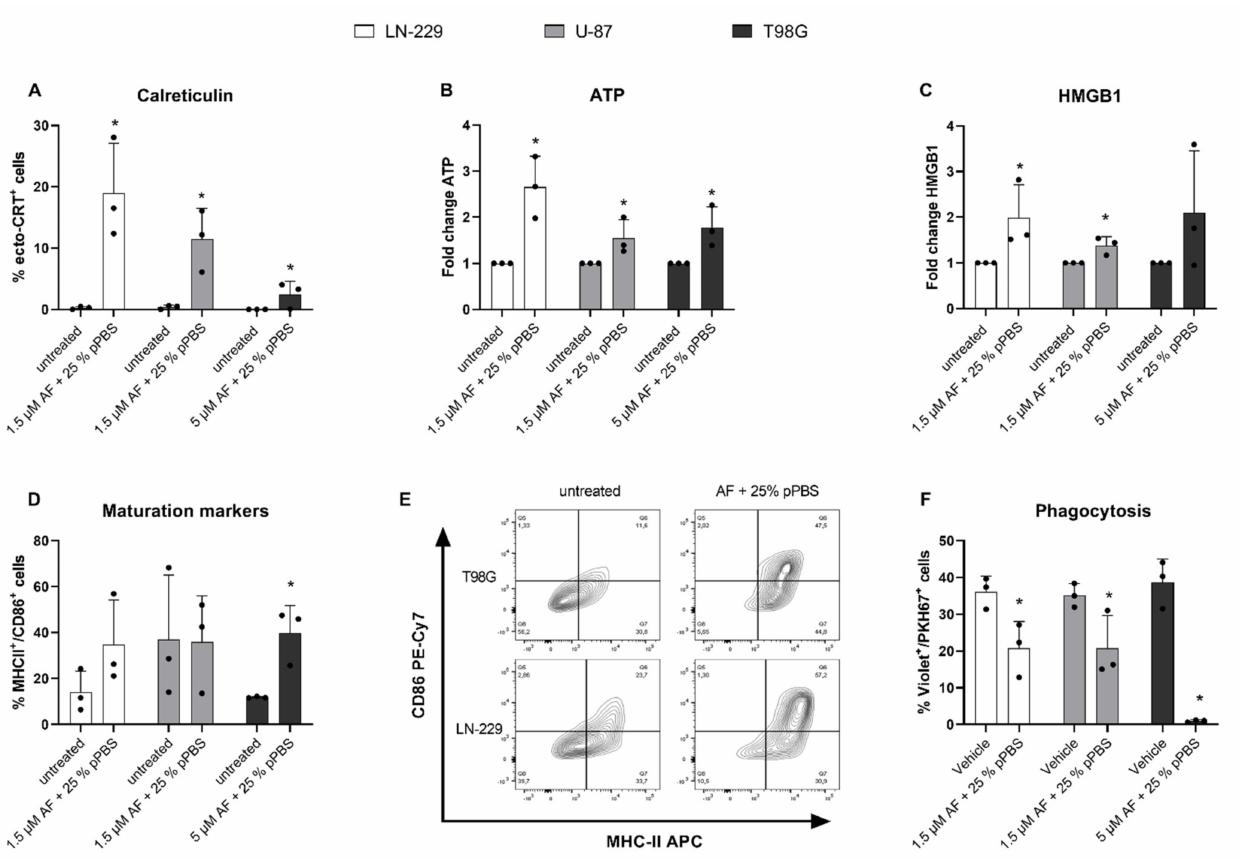
Figure 5. The effect of AF and pPBS combination treatment on the release of ICD danger signals, and DC maturation and phagocytosis. ( A ) Percentage of surface-exposed calreticulin (ecto-CRT) positive cells after 48 h of combination treatment with AF (1.5 µ M or 5 µ M) and pPBS (25%). ( B ) Secretion of ATP after 4 h of combination treatment with AF (1.5 µ M or 5 µ M) and pPBS (25%). These data represent the fold change of ATP secretion (nM range). ( C ) Secretion of HMGB1 after 48 h of combination treatment with AF (1.5 µ M or 5 µ M) and pPBS (25%). These data represent the fold change of ATP secretion (ng/mL range). ( D ) Percentage of MHC-II/CD86 double positive DCs after 48 h of co-culture with AF (1.5 µ M or 5 µ M) and pPBS (25%) combination-treated LN-229, U-87 or T98G cells (E:T ratio 1:1) using flow cytometry. ( E ) Representative contour plots of the DC population double positive for MHC-II and CD86 in coculture with either PBS-treated or combination-treated T98G (5 µ M AF + 25% pPBS) and LN-229 (1.5 µ M AF + 25% pPBS). ( F ) Percentage of phagocytosis after 48 h of violet-labeled DC in co-culture with AF (1.5 µ M or 5 µ M) and pPBS (25%) combination-treated PKH67-labeled GBM cells (E:T ratio 1:1). Phagocytosis of PKH67+ tumor cells by violet-labeled DCs is expressed as %PKH67+violet+ cells within the violet+ DC population. Graphs represent mean ± SD of ≥ 3 independent experiments. * p ≤ 0.05 denotes a statistically significant difference compared with untreated